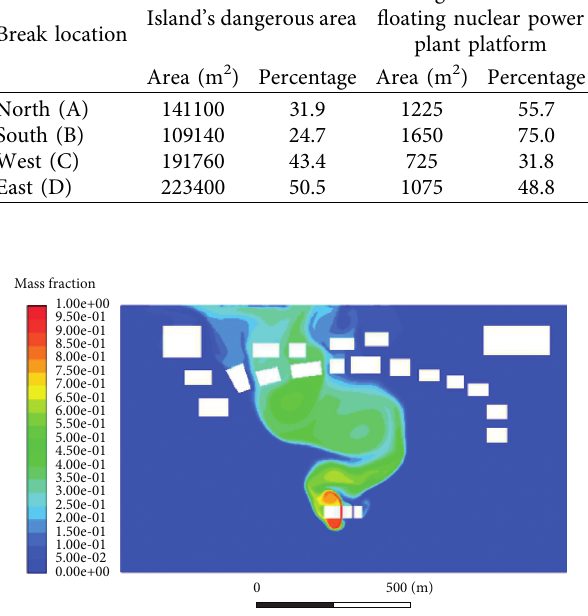
Figure 8: Radionuclide distribution rotating 90 ° clockwise at the northern break.